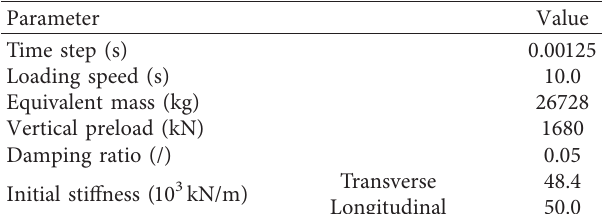
Table 4: Experiment